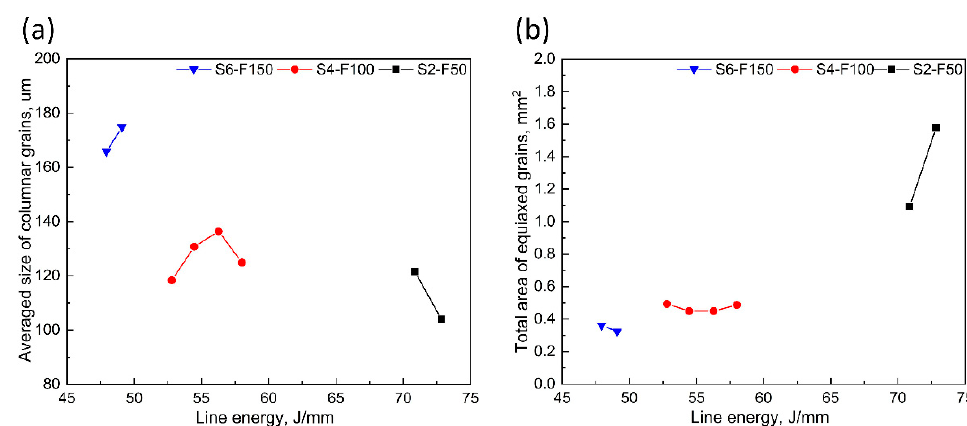
Figure 6. Distributions of ( a ) averaged grain size (length) of columnar grains and ( b ) total area of equiaxed grains in the weld zone as function of welding parameters, obtained from EBSD grain morphology maps. Note that welds with insufficient part-to-part bonding are not included.